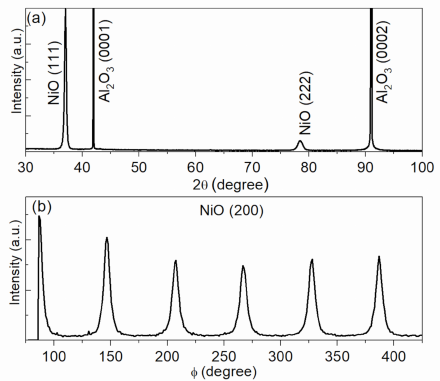
Figure 5. ( a ) θ –2 θ scan diffractograms of NiO thin films (about 200 nm thick) deposited on Al 2 O 3